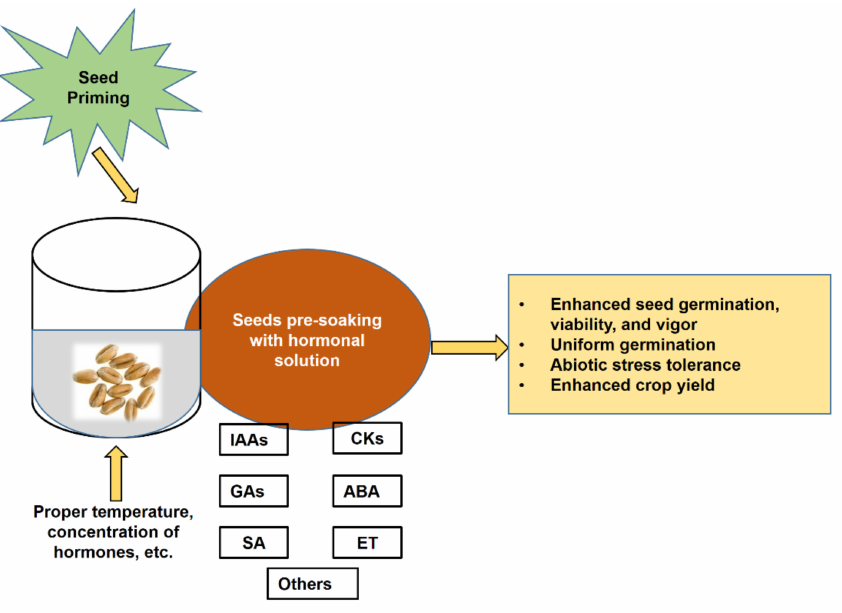
Figure 1. Schematic model showing possible effects of seed priming with